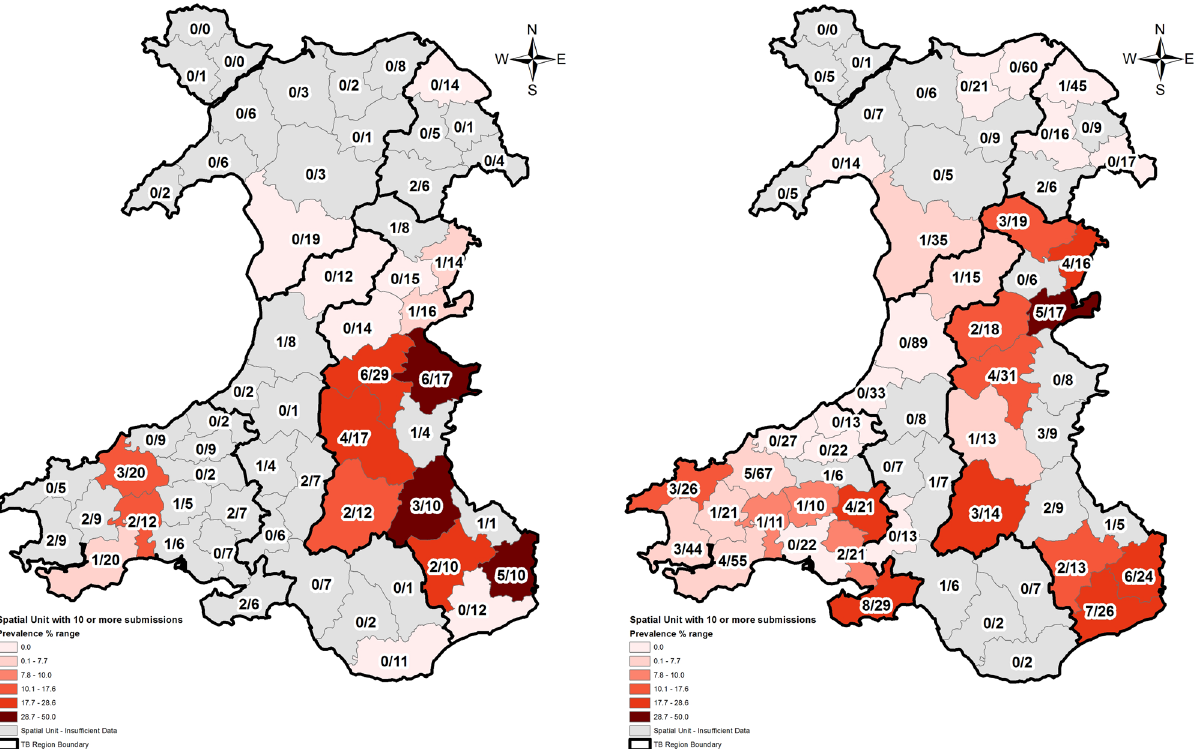
Figure 1. The original incorrect version of the Figure